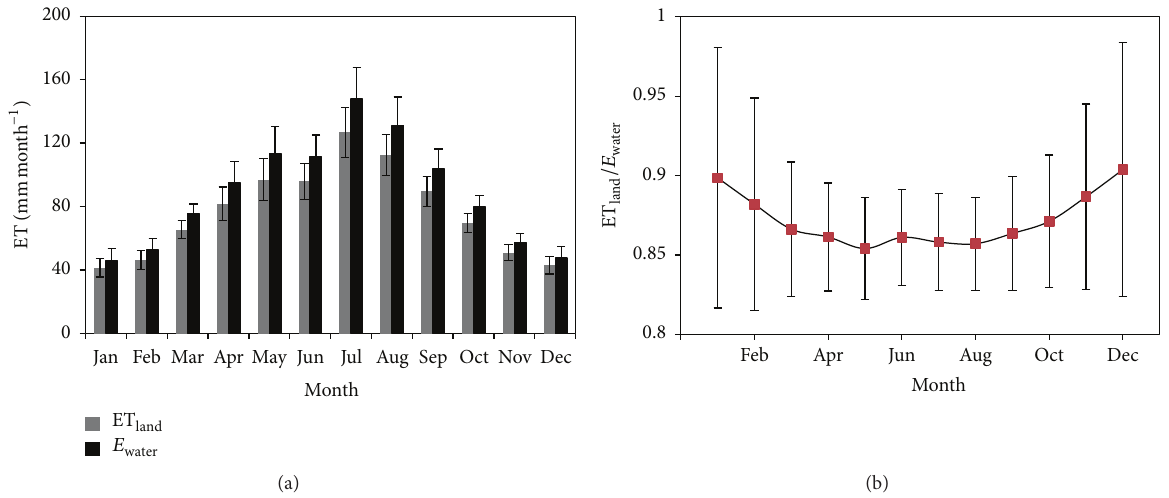
Figure 4: Monthly variations in (a) the mean land surface ET (ET land ) and water evaporation ( 𝐸 water ) and (b) the ET land / 𝐸 water averaged from 2000 to 2013. The error bars refer to ± 1 SD of the average.